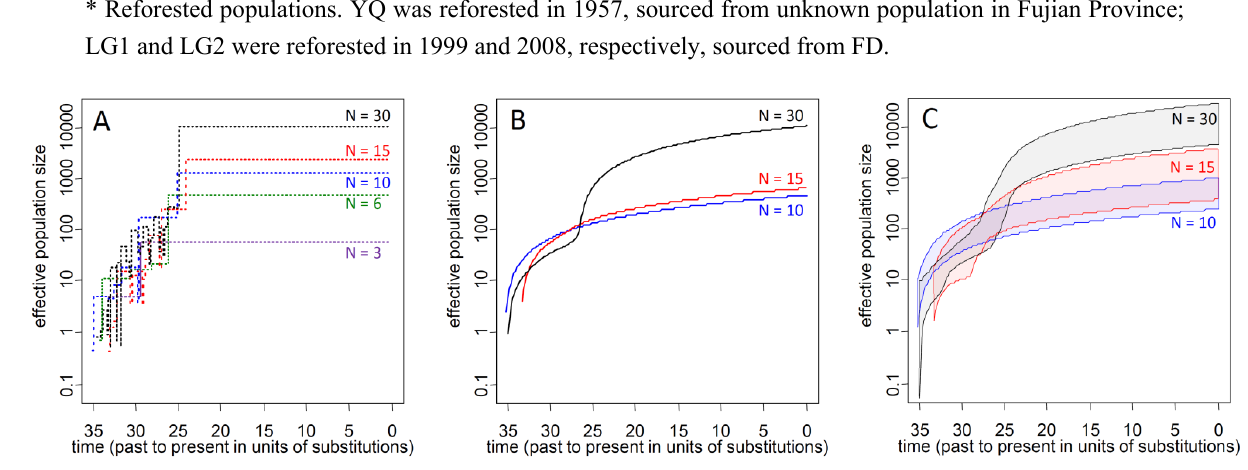
Figure 4. The Ne through-time-plots of the FD population estimated from 30 samples ( N = 30) and the reforested population simulated from 1/2 ( N = 15), 1/3 ( N = 10), 1/5 ( N = 6), and 1/10 ( N = 3) sample size of FD. ( A ) The classic skylines; ( B ) the medians of rjMCMC skylines; ( C ) the 95% CI of rjMCMC skylines. The rjMCMC skylines estimated from 20% and 10% Nc of FD are not shown due to small sample sizes ( N = 6 and N = 3, respectively). Individual simulation plots are shown in Supplementary Figure